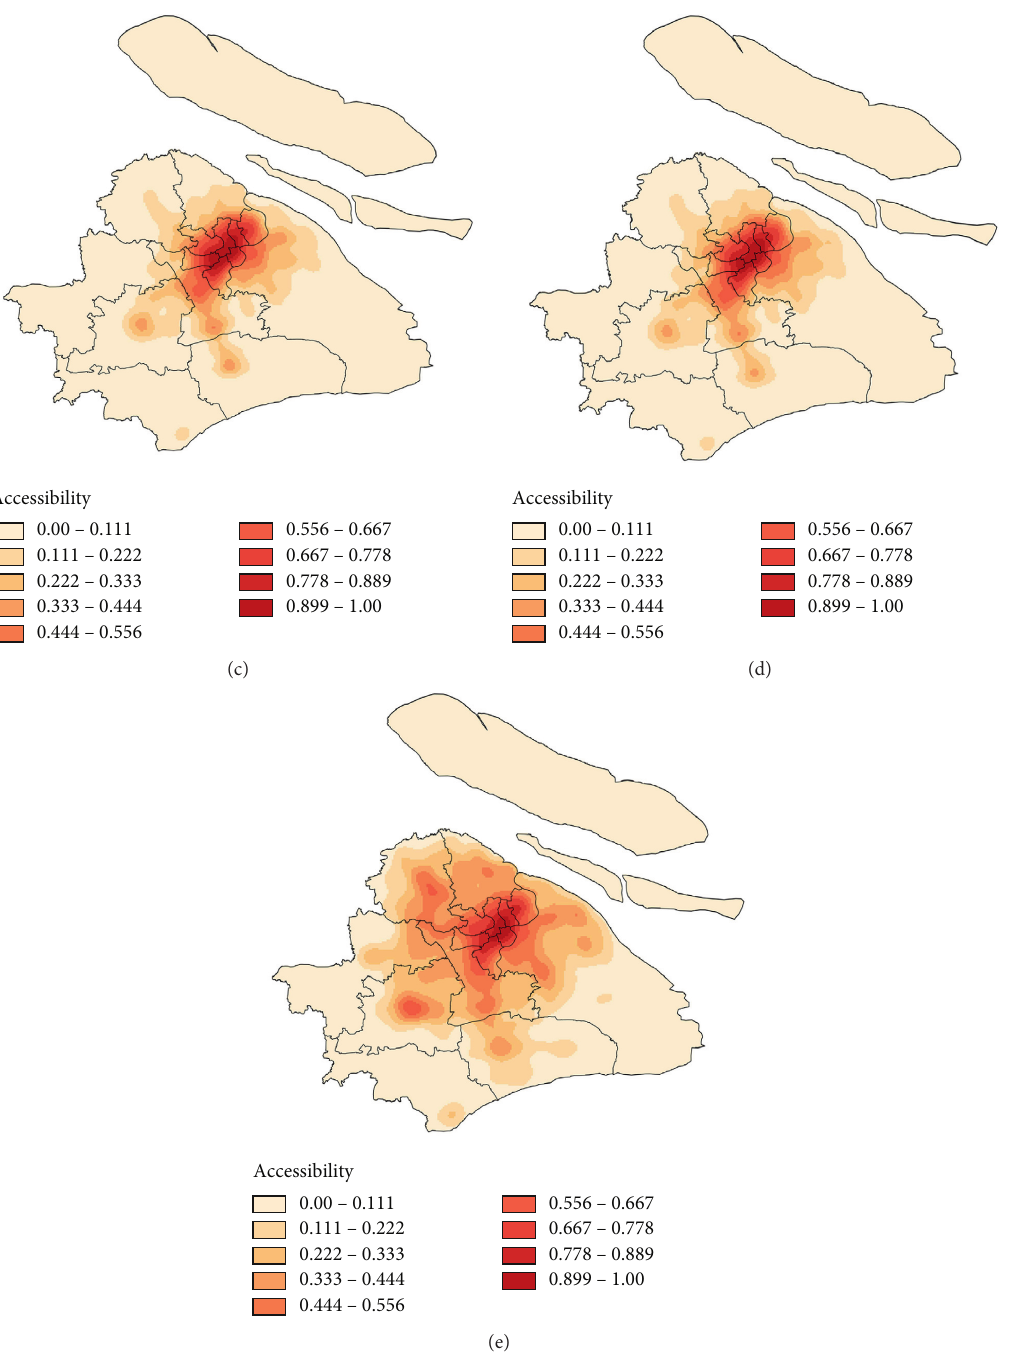
Figure 5: The distribution of indicators from SNA for the dockless sharing-bike network in Shanghai: (a) out-degree centrality distribution, (b) in-degree centrality distribution, (c) out-closeness centrality distribution, (d) in-closeness centrality distribution, and (e) betweenness centrality